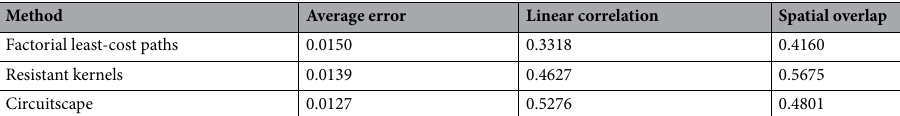
Table 3. Overall results from the second analysis, which tested the accuracy of factorial least-cost paths, resistant kernels and Circuitscape across 147 connectivity scenarios.